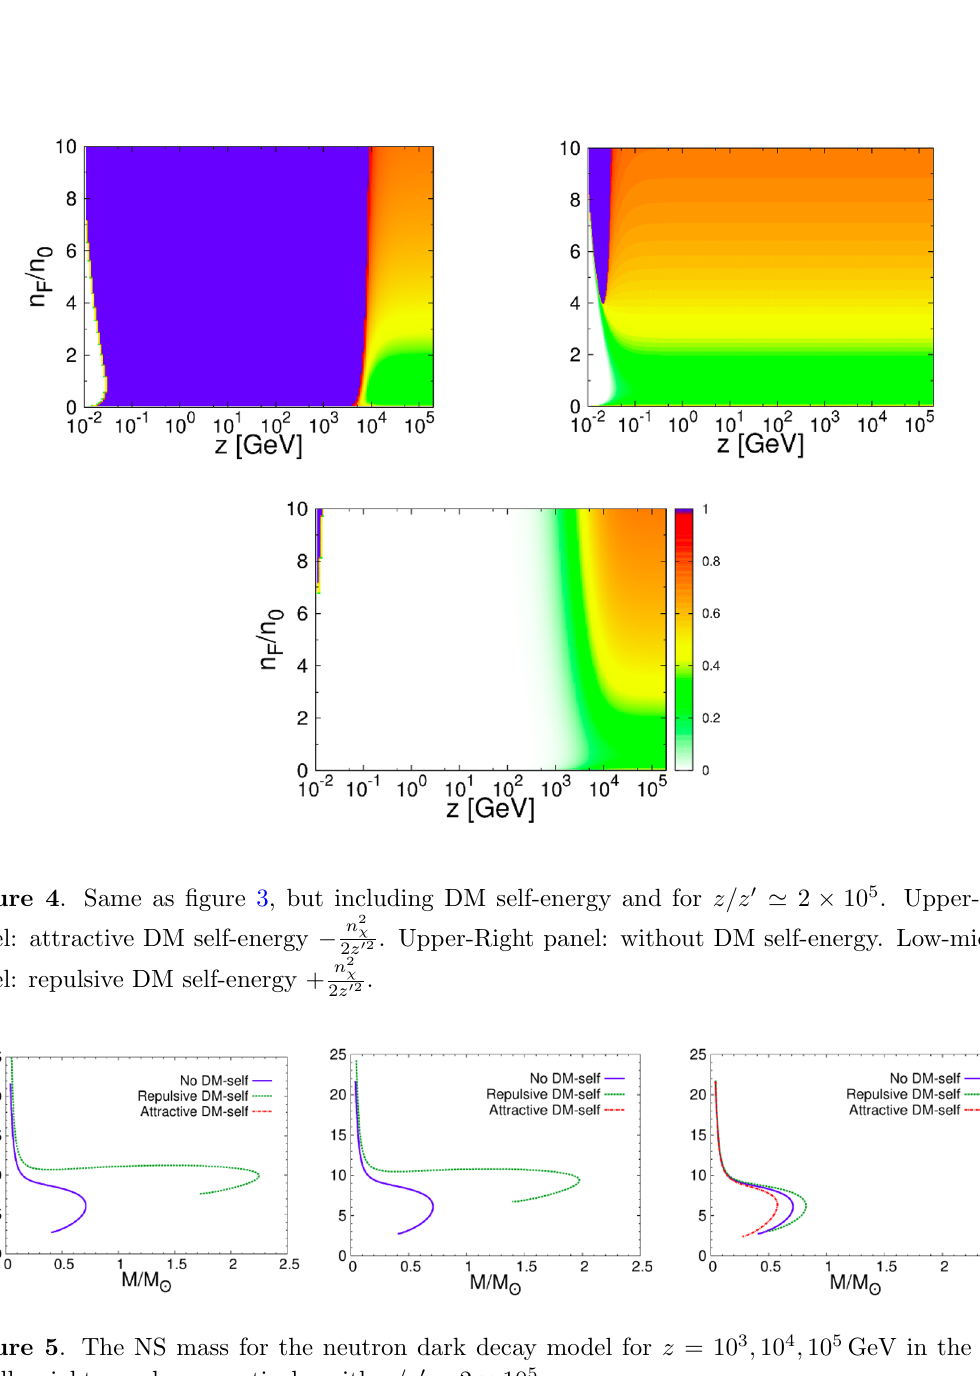
Figure 5 . The NS mass for the neutron dark decay model for z = 10 3 ; 10 4 ; 10 5 GeV in the left, middle, right panels, respectively, with z=z 0 ’ 2 (cid:2) 10 5